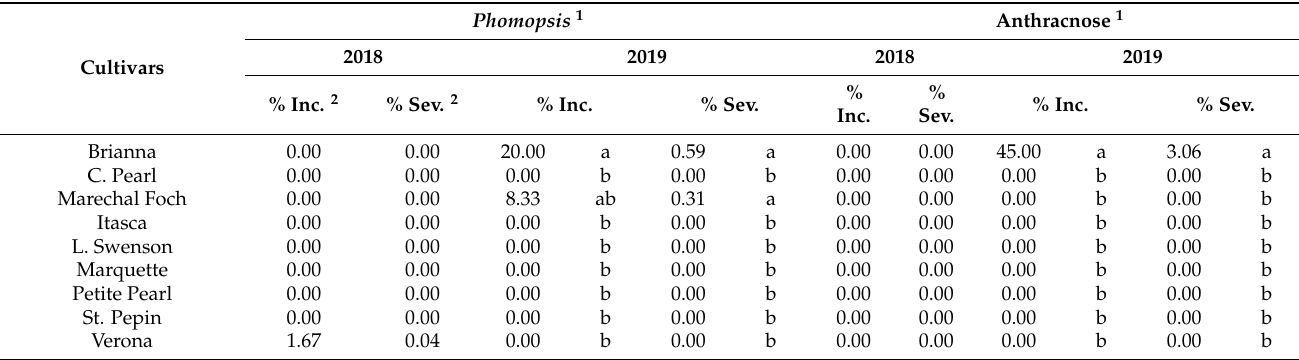
1 Values represent the mean from six replicate two-vine plots per cultivar of disease incidence on 20 leaves per plot. Disease severity (area infected) was rated using the Horsfall-Barratt scale and converted to percentages using Elanco’s conversion tables. Means followed by the same letters within columns are not significantly different according to Tukey’s Honest Significant Difference (HSD) Test ( p ≤ 0.05). 2 Inc. = Incidence; Sev. = Severity. In 2018, the incidence of black rot (Table 3) was highest in ‘Marquette’ (85.0% of fruit was affected) followed by ‘Brianna’ (73.3%). ‘Petite Pearl’ had moderately high incidence (48.3%), followed by ‘Itasca’ (30.0%) and ‘St. Pepin’ (20.0%). ‘Louise Swenson’ and ‘Verona’ had the lowest incidence of black rot on fruit (1.7 and 3.3%) among all cultivars, and the severity followed a similar trend to the incidence in that year. The black rot incidence and severity were greater overall in 2019, with all cultivars having incidence above 94%, except the severity of black rot damage among cultivars: ‘Marechal Foch’ had the most severe and ‘Petite Pearl’ had the lowest severity of the disease on fruit in that year.